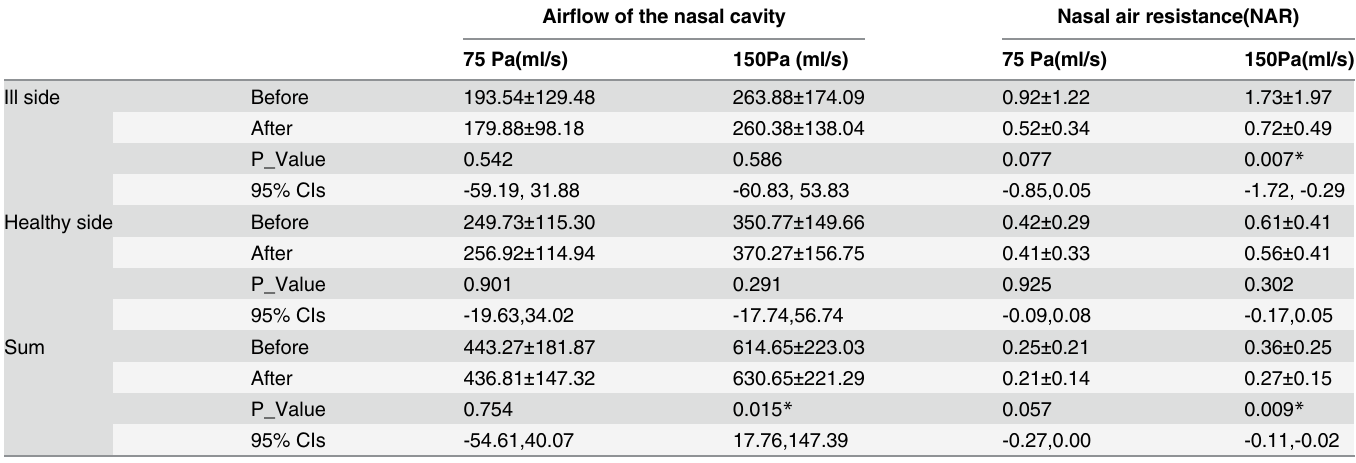
Table 3. The airflow of the nasal cavity and nasal air resistance (NAR) at the differential pressure 75/150 Pa before and after obturator placement (n = 26, ˉ x ± s).